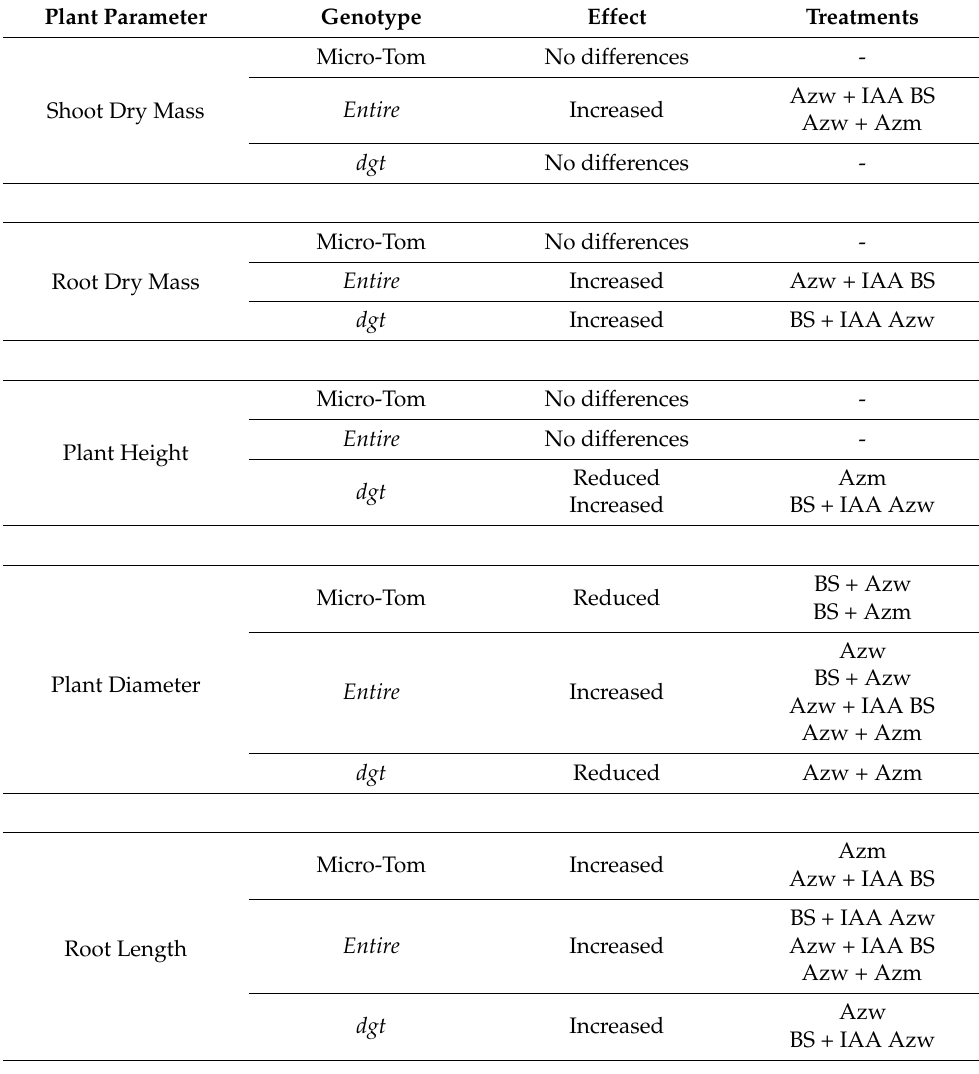
Table 2. Effects of inoculation of the various treatments that differed from the control treatment in relation to the plant parameters analyzed in the tomato genotypes Micro-Tom, Entire and dgt